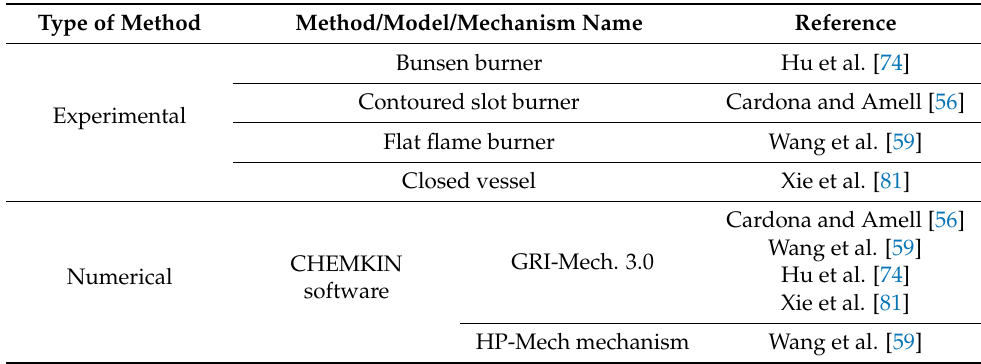
Table 6. Summary of experimental and numerical methods for obtaining the laminar burning velocity of biogas-O 2 -air mixtures described in the present